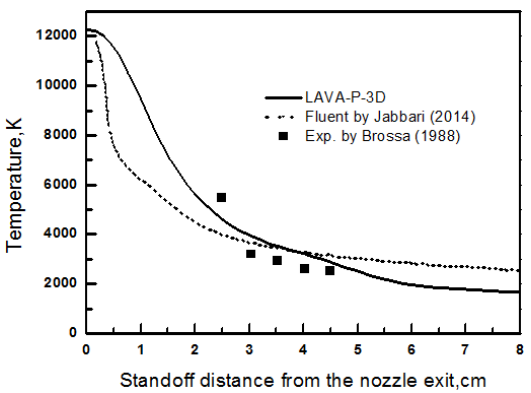
Figure 5. Comparison of gas temperature with published numerical (Reproduced with permission from [8]. Copyright Courtesy of Jabbari, 2014) and experimental data (Reproduced with permission from [27]. Copyright Courtesy of Brossa, 1988).